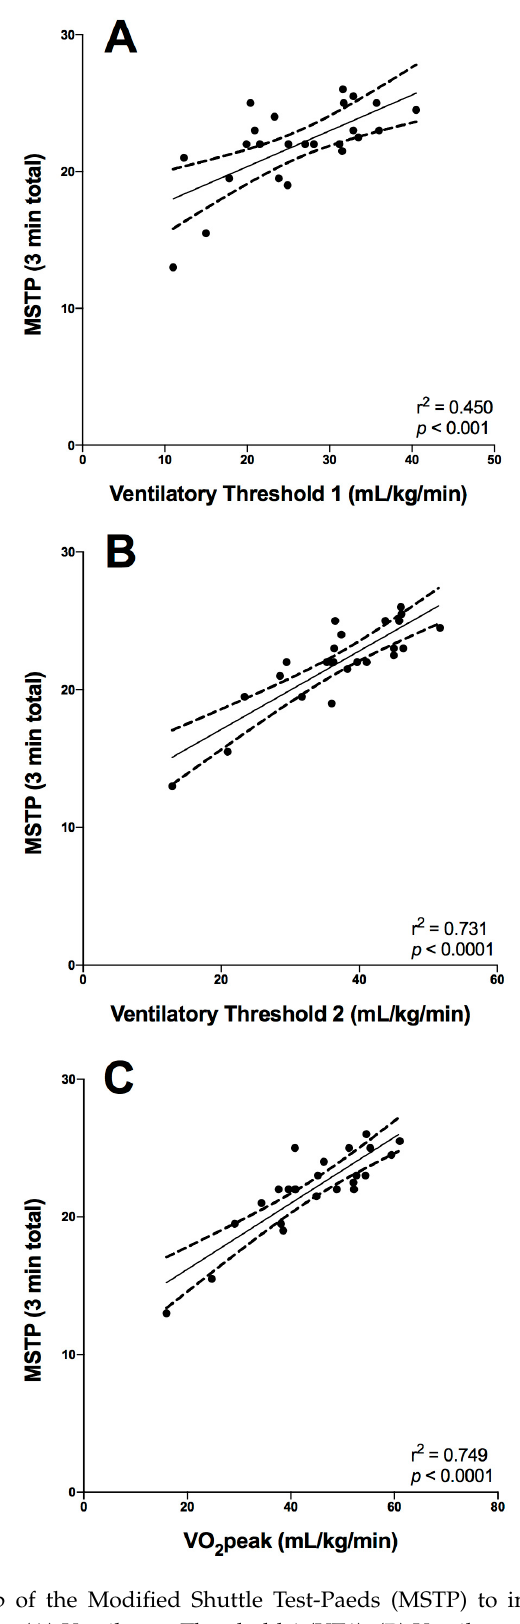
Figure 1. Relationship of the Modified Shuttle Test-Paeds (MSTP) to important parameters of cardiorespiratory fitness; ( A ) Ventilatory Threshold 1 (VT1), ( B ) Ventilatory Threshold 2 (VT2) and, ( C ) Peak Oxygen Uptake (VO 2 peak).